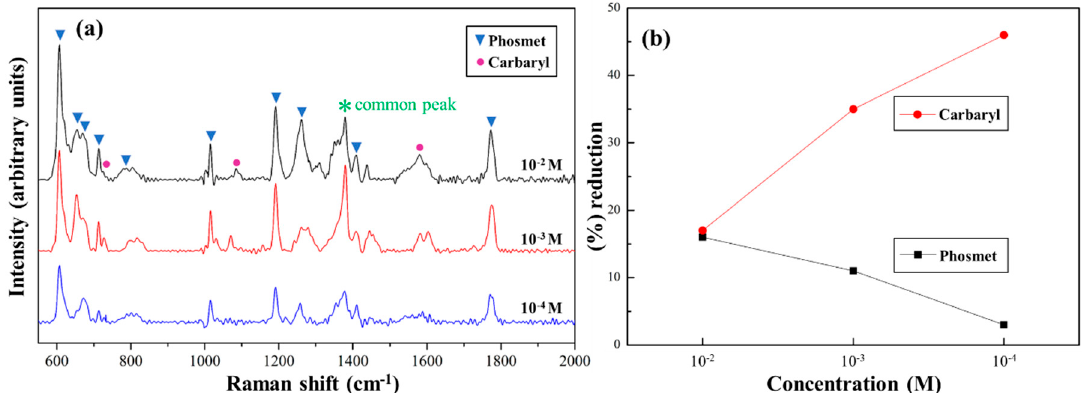
Figure 5. ( a ) Average SERS spectra of equimolar mixtures of phosmet and carbaryl at varying concentrations show that Au NPs (3.0) / p ZrO 2 is capable of multiplex detection; ( b ) Plot of the % reduction (from standard solution to mixture condition) in the peak intensity ratios obtained from the two major characteristic peaks of each pesticide.